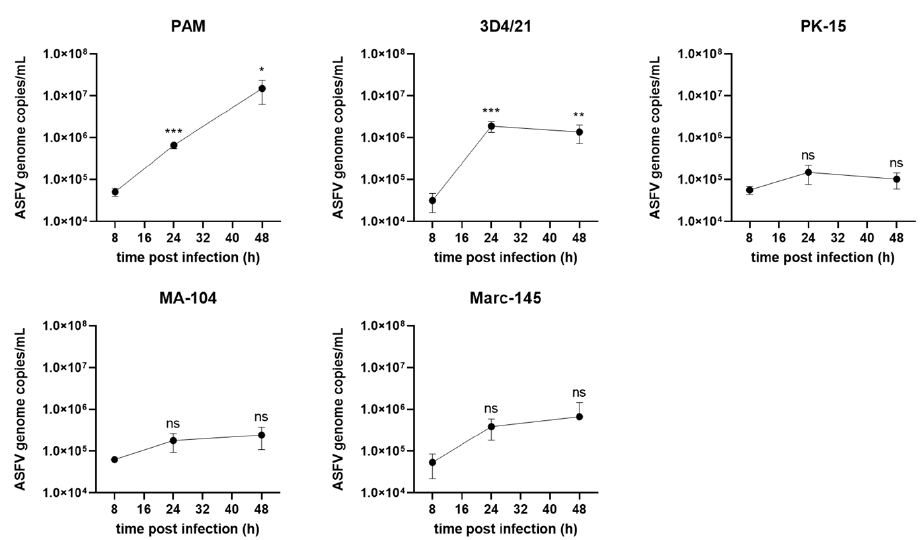
Figure 4. ASFV genomic DNA quantification during genome replication in PAMs, 3D4/21, PK − 15, MA − 104 and Marc − 145 cells. The cells were infected with ASFV at 5 MOI for 2 h at 37 °C. After washing three times with PBS, and incubation with fresh medium, the viral DNA was extracted from the infected cells at 8, 24 and 48 hpi and quantified by real-time PCR with primers targeting B646L gene. Results are presented as the mean ± SD of data from three independent experiments; ns, not significant; *, p < 0.05; **, p < 0.01, ***, p <